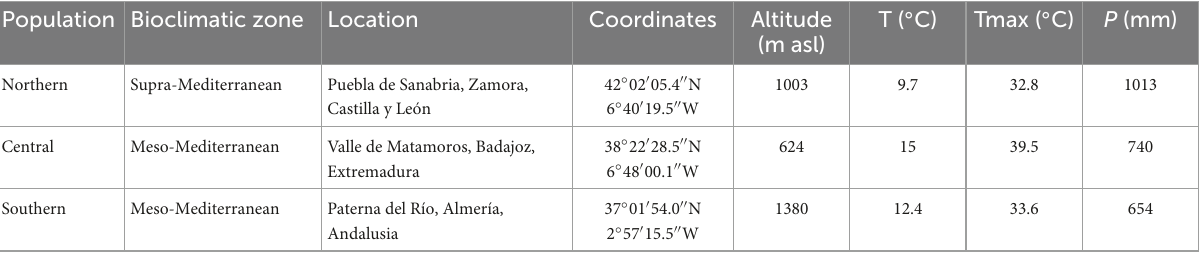
TABLE 1 Description of the three Spanish populations of Castanea sativa assessed. Population Bioclimatic zone